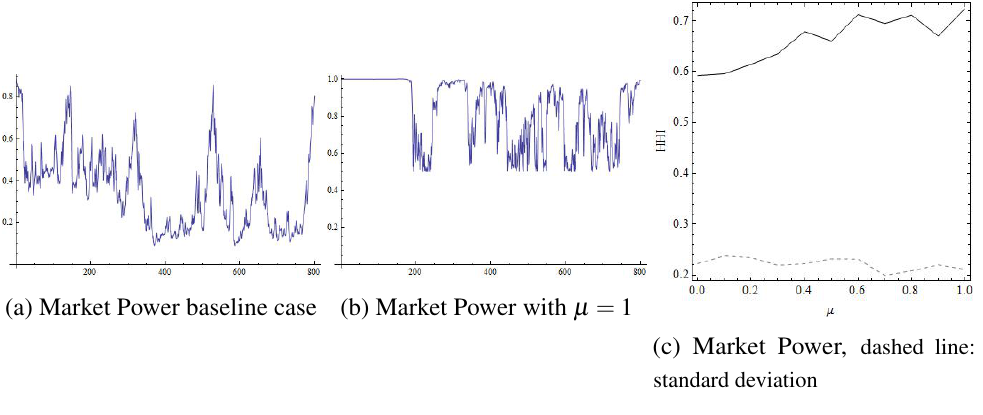
Figure 2: Impact of µ on market